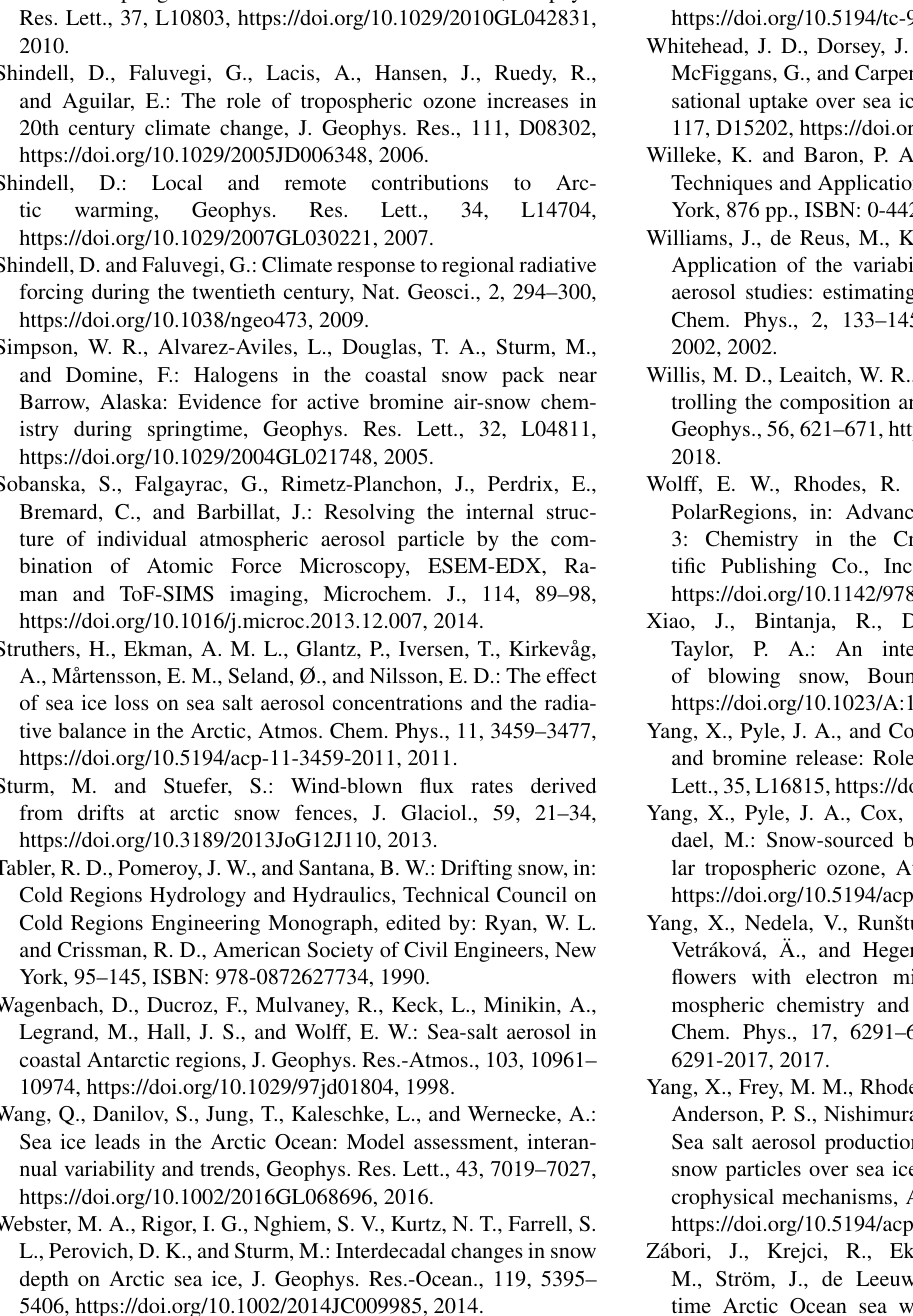
Tabler, R. D., Pomeroy, J. W., and Santana, B. W.: Drifting snow, in: Cold Regions Hydrology and Hydraulics, Technical Council on Cold Regions Engineering Monograph, edited by: Ryan, W.